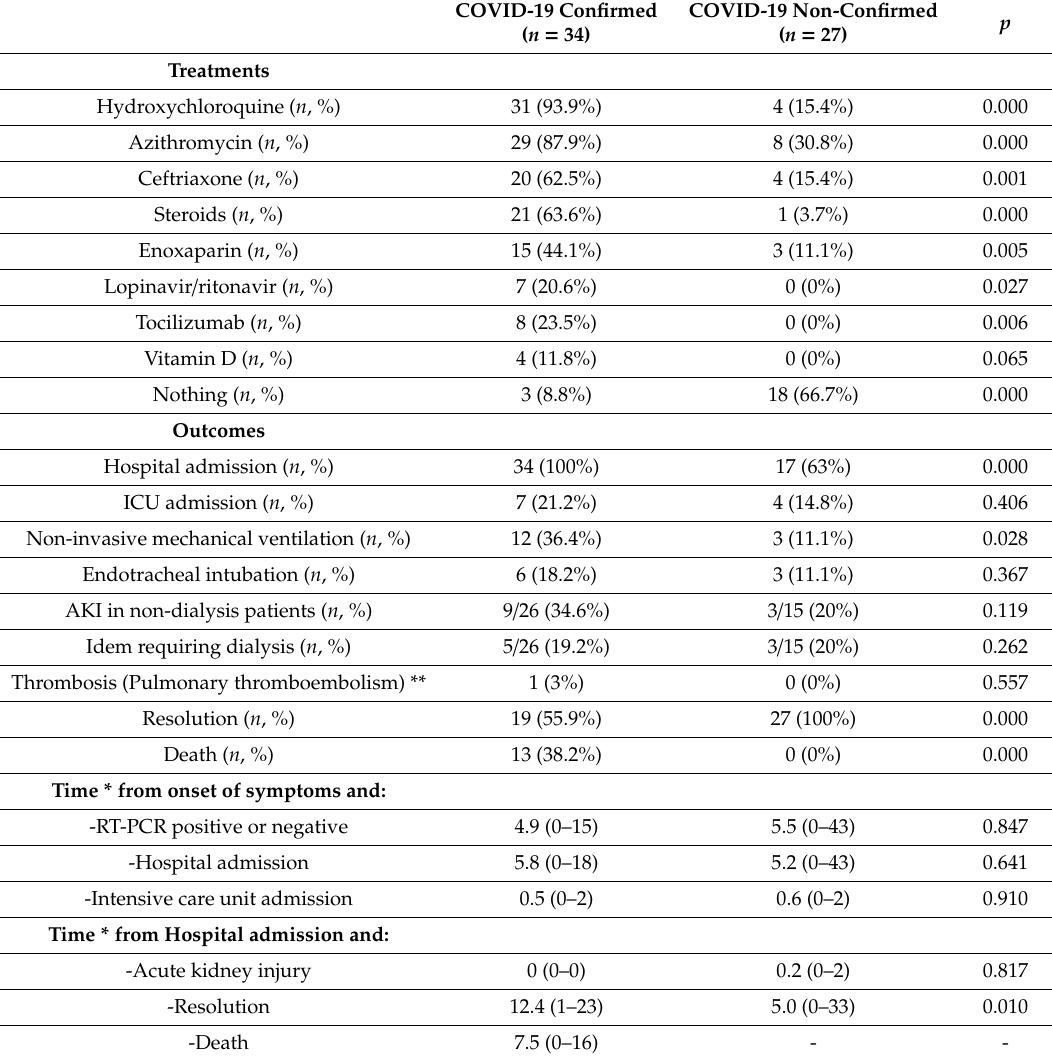
Table 3. COVID-19 treatments and outcomes in confirmed and non-confirmed cases.